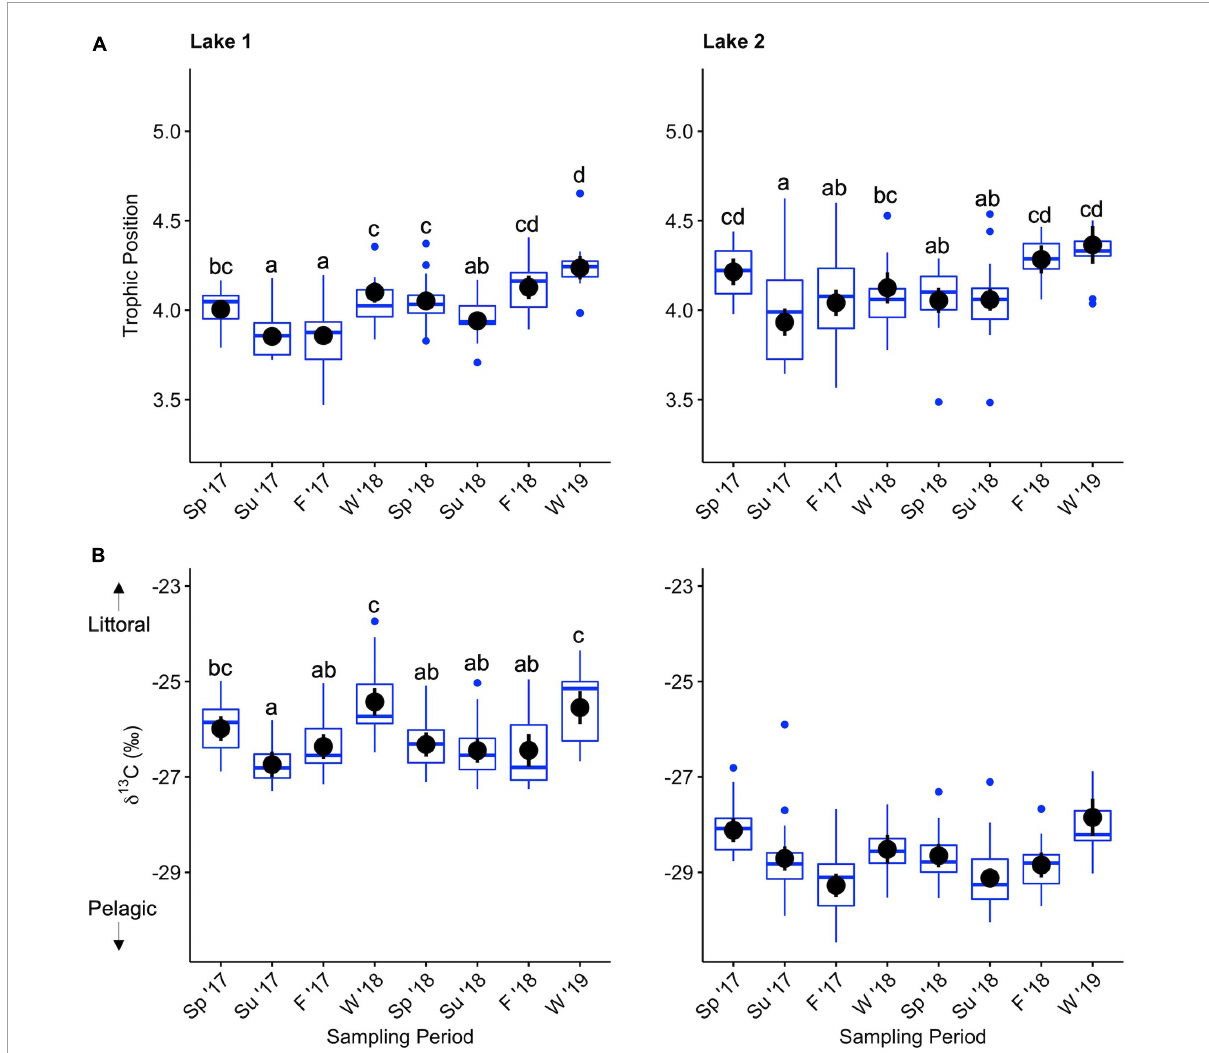
FIGURE6 Boxplot of trophic position (A) and lipid corrected δ 13 C (B) of lake trout liver in Lake 1 (+ cisco; left) and Lake 2 (– cisco; right) over 2 years of sampling during each season. Black dots are the estimated marginal means and vertical lines through the black dots are the associated confidence intervals. Different letters indicate a significant difference in the mean values between sampling periods. Note that post-hoc tests were not performed on δ 13 C in Lake 2 due to an interaction between fish length and sampling period that would make results